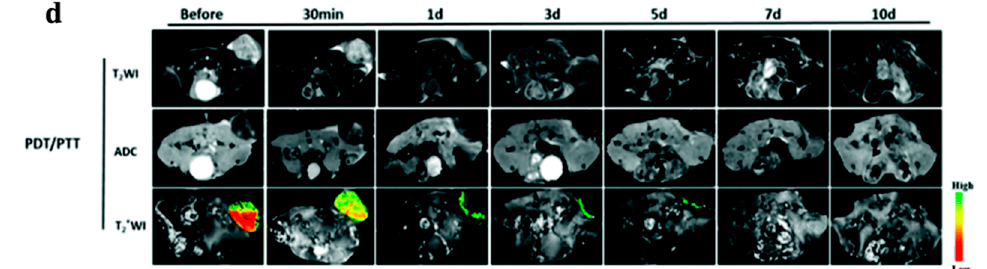
Figure 12. T 2-Weighted, ADC-mapping, and T*2-weighted images were taken at different time points of PDT, PTT, and PDT/PTT treatments. A pseudocolor R*2-map was overlapped with the T*2 images to highlight the intensity changes. ( a ) Control group; animals were injected with PBS and received no photoirradiation; ( b – d ) animals were treated with PDT, PTT, or PDT/PTT combination, respectively. For the treatment groups, 200 µL of 2 mg·mL − 1 GO-PEG-Ce6 (1.4 mM Ce6) was injected. d: day. Image adapted with permission from [41].